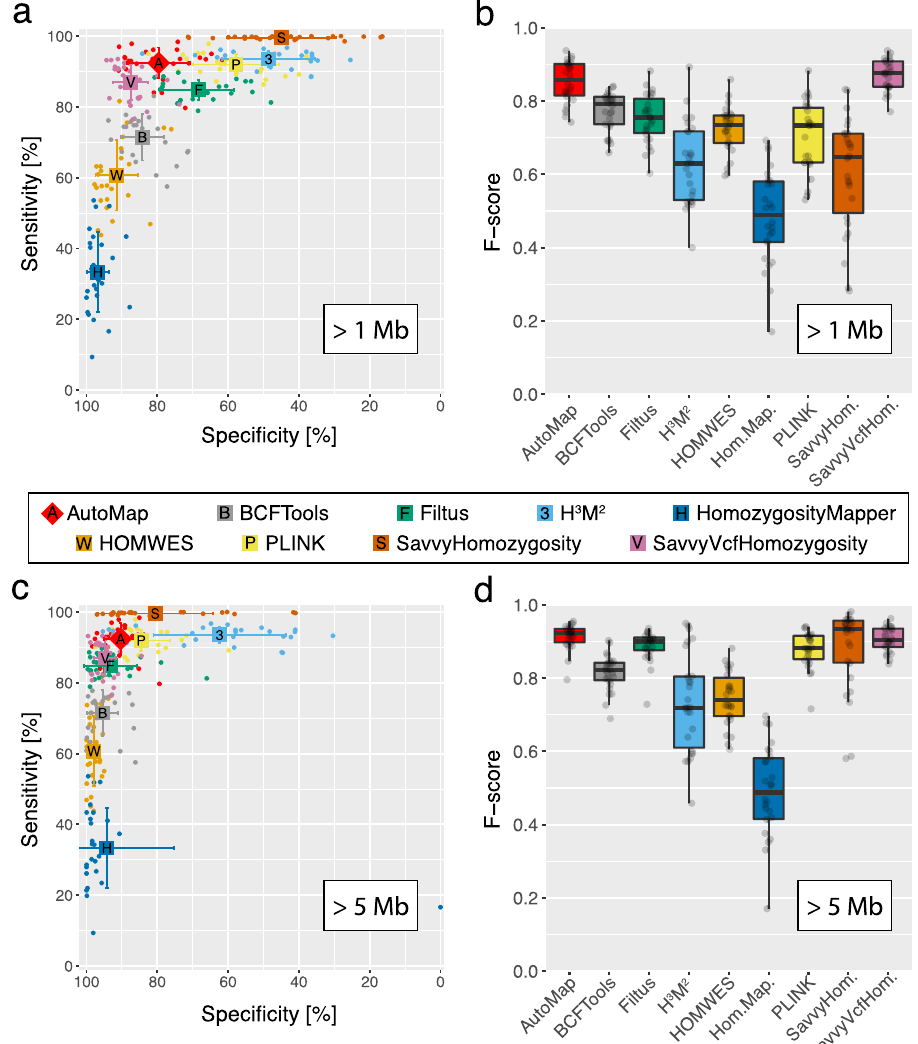
Fig. 2 Performance of AutoMap and other tools on data from the validation set. a , b Performance of AutoMap for ROHs larger than 1 Mb (Megabase): a speci fi city and sensitivity; b F -score. c , d Same analyses as in a , b , but limited to ROHs with sizes of 5 Mb or higher (most likely to contain causative recessive mutations in medical genetics practice, according to published literature). Error bars represent standard deviations of the mean. For boxplots ( b , d ), the middle band indicates the median, boxes represent the fi rst and the third quartiles, and whiskers indicate the largest observation smaller than or equal to the fi rst quartile − 1.5 x IQR (the interquartile range) and the smallest observation greater than or equal to to third quartile + 1.5 x IQR. N = ~2.7 million DNA variants per tool and per test. Source data are provided in the Source Data